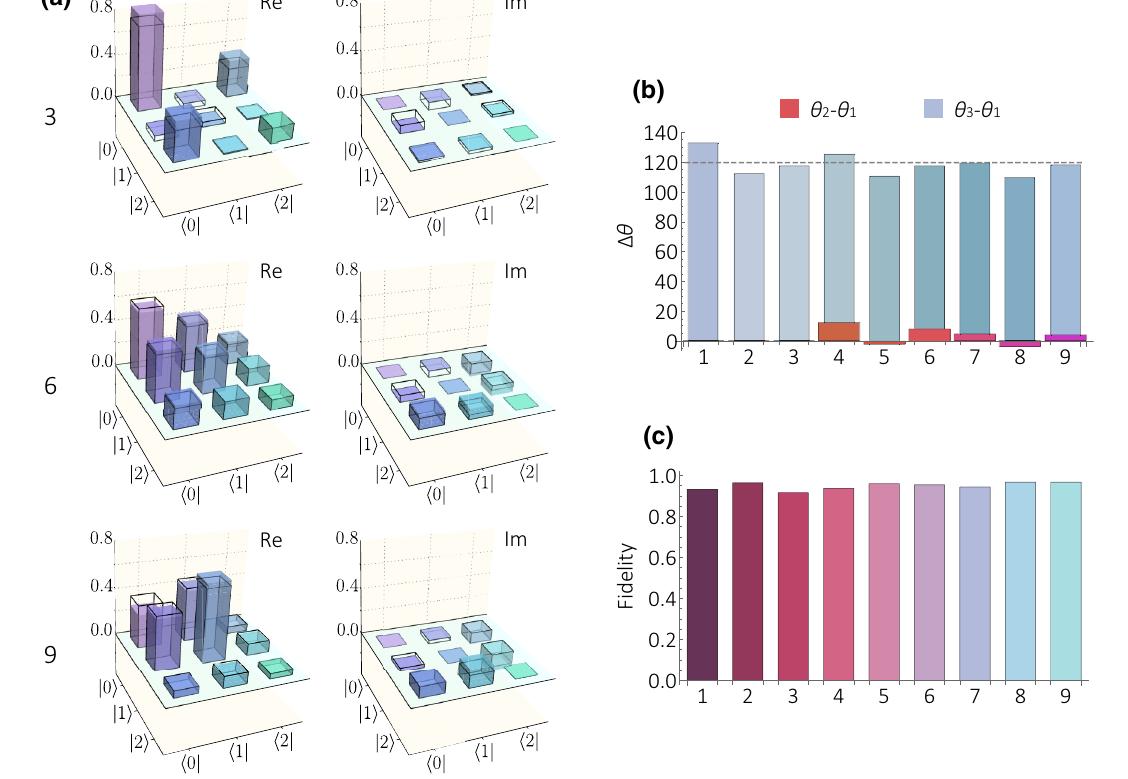
FIG. 7. An additional experimental result on simulating the braiding of parafermions. (a) The real and imaginary parts of the sample density matrices for data points | ψ 3 (cid:2) , | ψ 6 (cid:2) , and | ψ 9 (cid:2) after braiding from quantum state tomography. The edge and the filling of the cuboids show the theoretical values and the experimental results from quantum process tomography, respectively. (b) The calculated phase change during the braiding evolution for each data point. The blue bars show the relative phase between | ψ S a theoretical value of 2 π/ 3, and the red bars show the relative phase between | ψ S calculated state fidelity between the experimental result and the theoretical prediction for each data